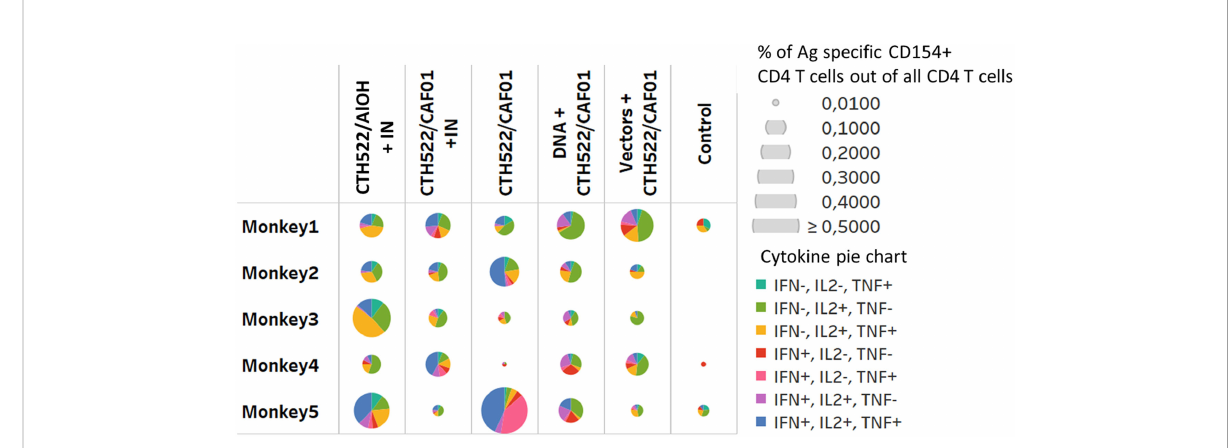
FIGURE 5 CD4 T cell responses. Multifunctional analyses week 22. Cytokine production by CD4 + T cells assayed by ICS. Multifunctional responses after stimulation with pools of overlapping peptides from MOMP are represented. The size of each pie is proportional to the percentage of CD154 + CD4 + T cells expressing at least one cytokine, including IFN- g , TNF- a , and IL-2, and the proportions of cells expressing IFN- g and/or TNF- a and/or IL-2 cytokines are displayed in each